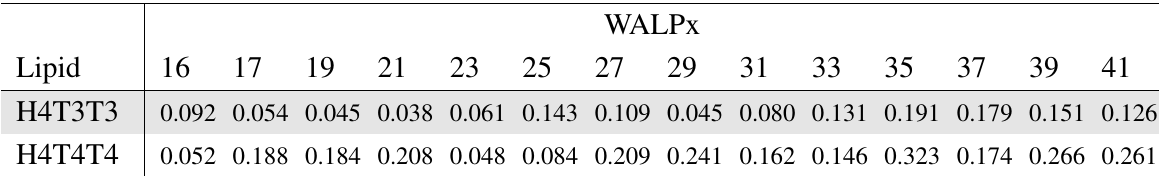
Table 2. The CRMS (in nm) after 24 ns of coarse grained molecular dynamics simulations α for WALP-peptides of different length embedded in two different lipid membranes. The presented values are an average of the final 240 ps of the simulations, and for each of the simulations the standard deviation for the CRMS equals 0.005 α